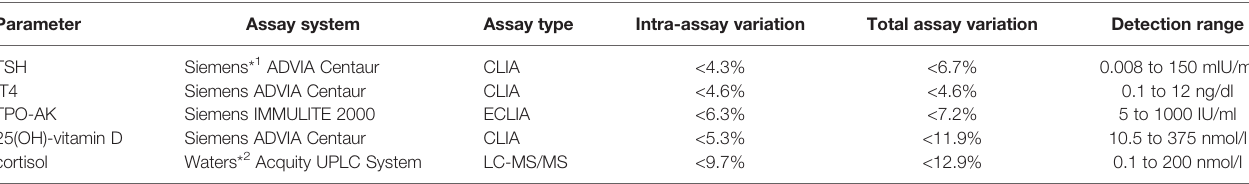
TABLE 1 | Assays and their performance